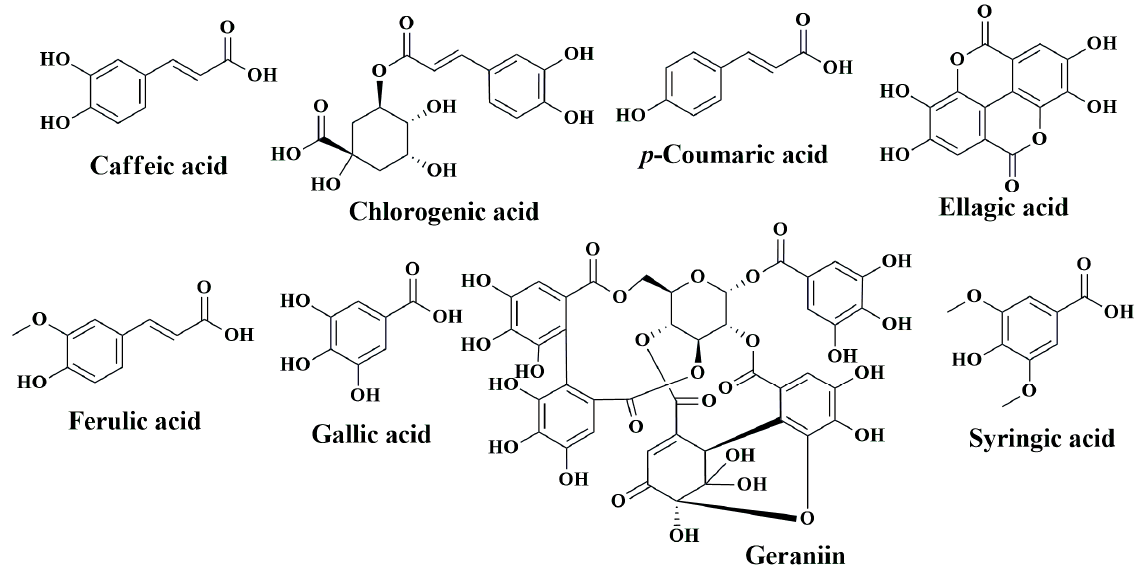
Figure 3. Chemical structures of phenolic acids with in vivo anti-CRC activities.